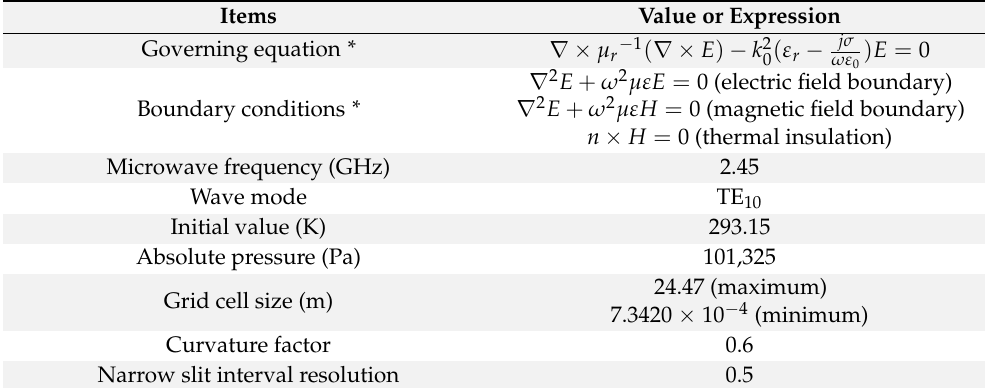
Table 3. The governing equation and boundary conditions of Maxwell’s equations and other fixed simulation